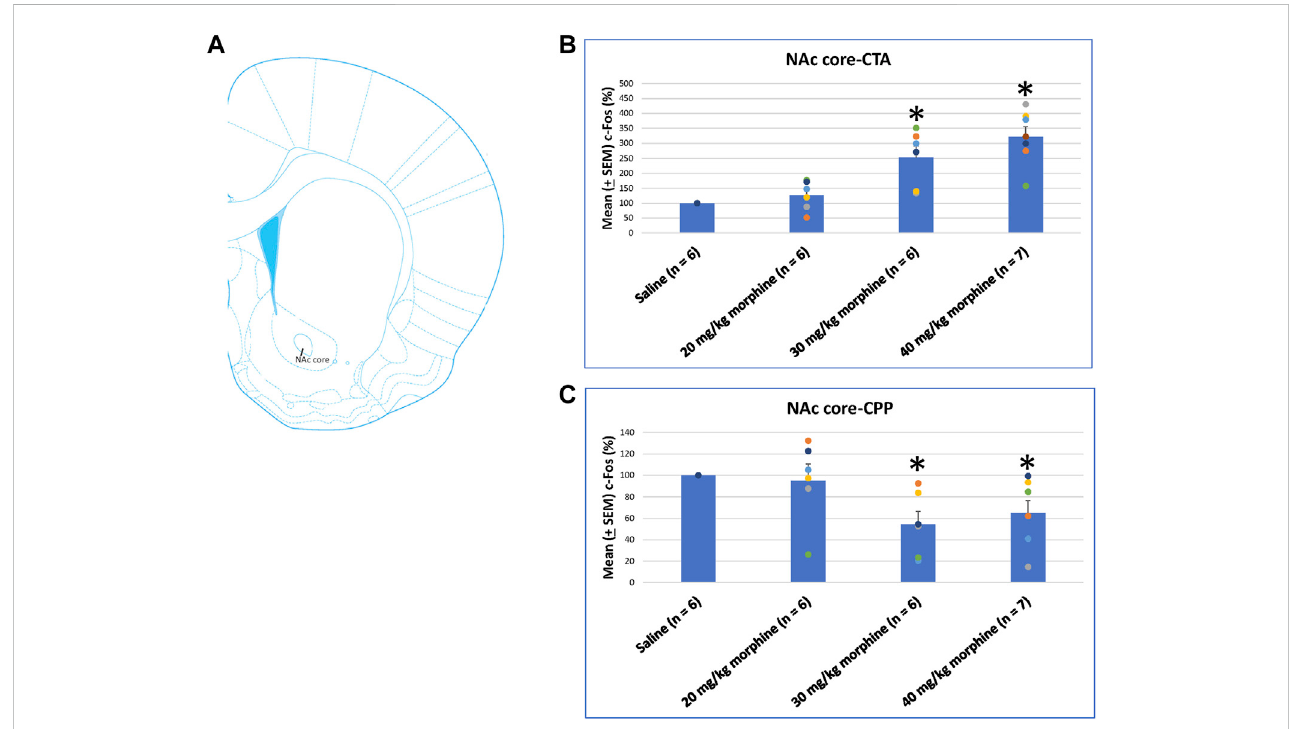
FIGURE 9 (A) Representativeimageofc-Fosimmunoreactivityinthenucleusaccumbenscore(NAccore).Mean(±SEM)c-Fos(%)intheNAccorefollowing (B) CTA and (C) CPP tests. * p < 0.05 when comparing the saline for CTA and CPP (both, n = 6) or with morphine in doses of 20 mg/kg for CTA and CPP (both, n = 6), 30 mg/kg for CTA and CPP (both, n = 6), and 40 mg/kg for CTA ( n = 6) and CPP ( n =